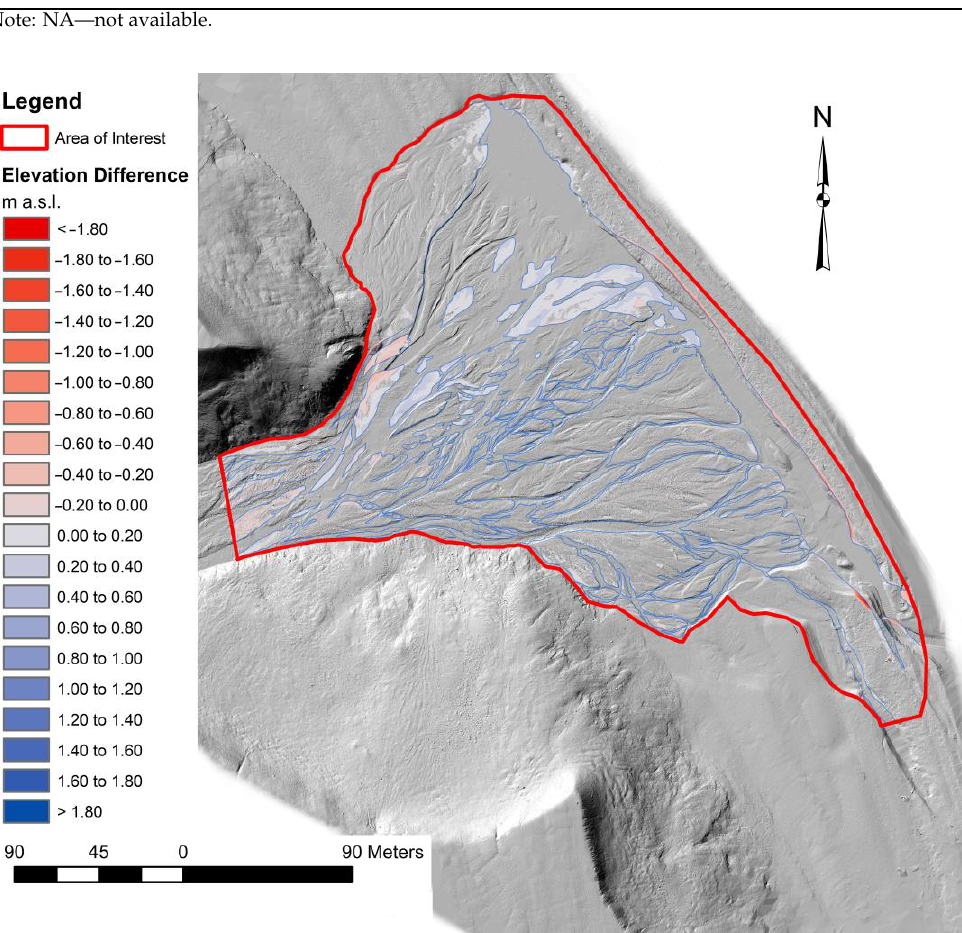
Figure 7. Geomorphic changes in the Scott River alluvial fan non-flooded area (AoI NFA ) for the 2013 flood event period. AoI for the AoI NFA with MinLoD = 0.02. Hillshades map is shown after DoD for